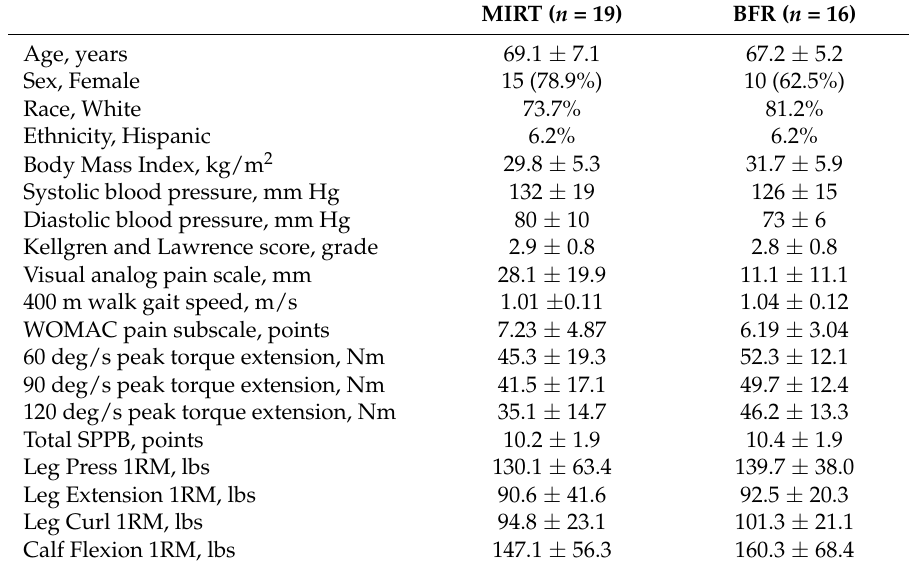
Figure 1. Flow diagram of study progress in the Consolidated Standards of Reporting Trials (CONSORT) Group. Table 1. Participant demographic baseline